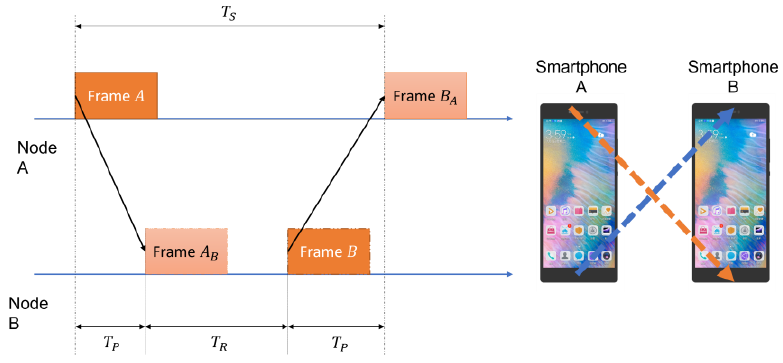
Figure 3. Mutual ranging flow chart based on smartphones.